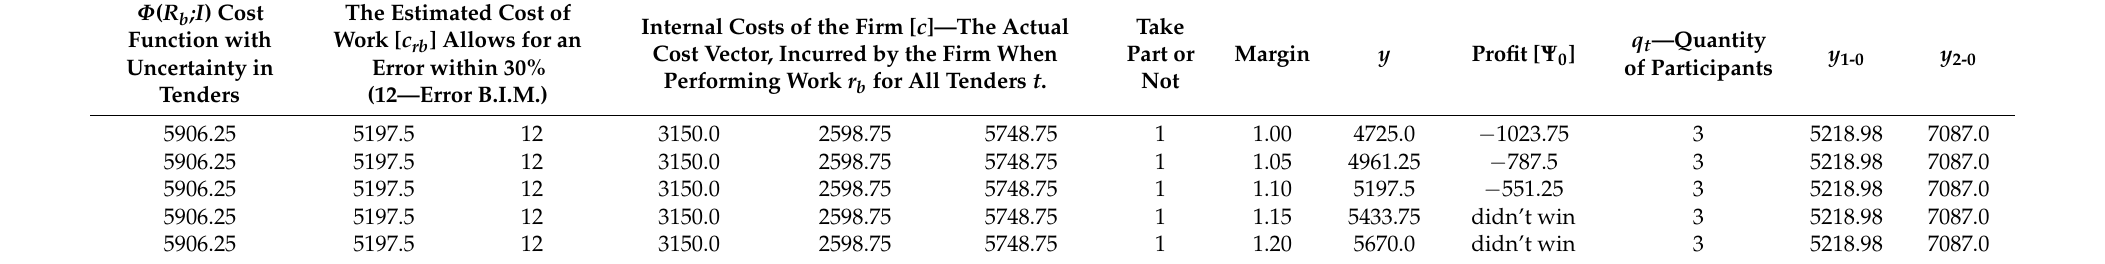
Table 1. Fragment of the spreadsheet list “Subordinate Model B.I.M.”.